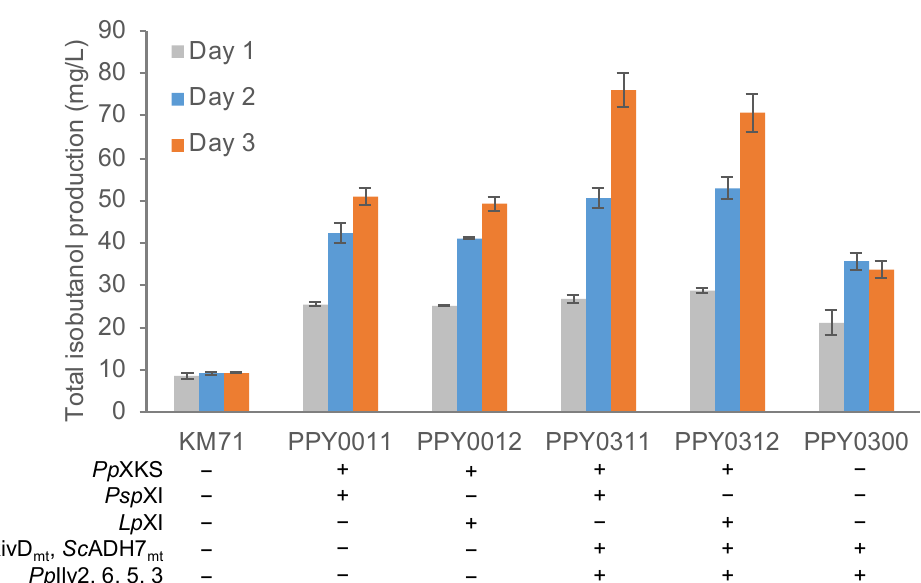
Figure 3. Total Isobutanol production of engineered P. pastoris in a mixed-carbon source medium. Engineered strains were precultured in 5-mL aliquots in MGYH minimal medium (2% glycerol) overnight and used to inoculate 5 mL yeast selective medium (2% total sugar; 1.70% glucose and 0.30% xylose) to achieve an initial optical density of 0.05 at 600 nm (OD 600 ). The cultures were grown at 30 ◦ C and 250 rpm in an orbital shaking incubator. Samples were taken at 24, 48, and 72 h for isobutanol quantification and OD 600 measurement. Values are the mean of three biological replicates ± standard deviation (n = 3). Lp, Lachnoclostridium phytofermentans ; Psp, Piromyces sp. E2; Pp, Pichia pastoris ; Ll, Lactococcus lactis